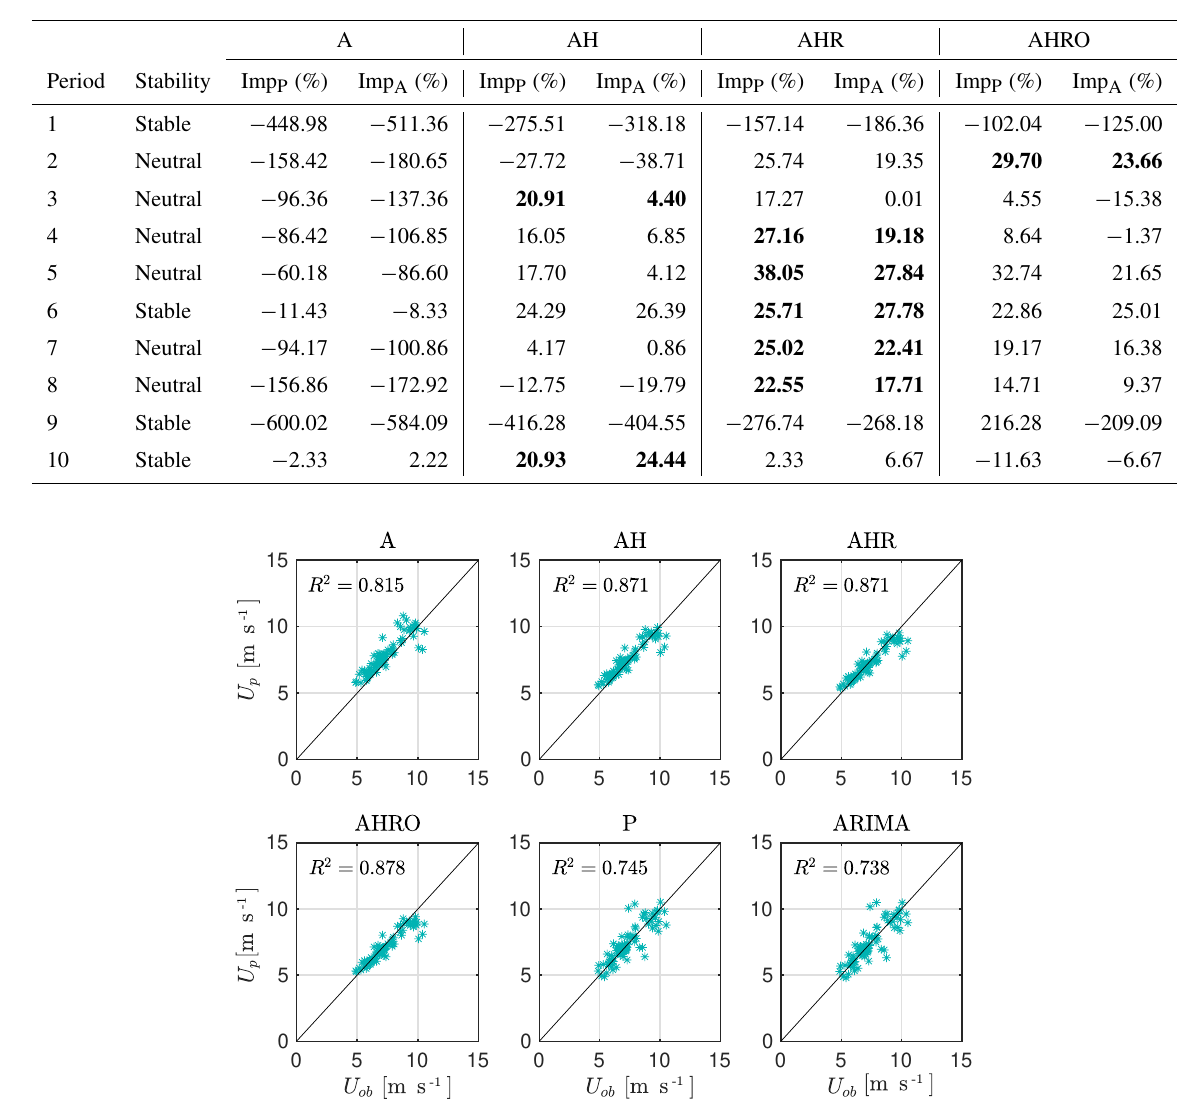
Figure 13. Comparison between the observed ob and predicted p wind speed for all evaluated models for period 6 (stable) with N = 95.